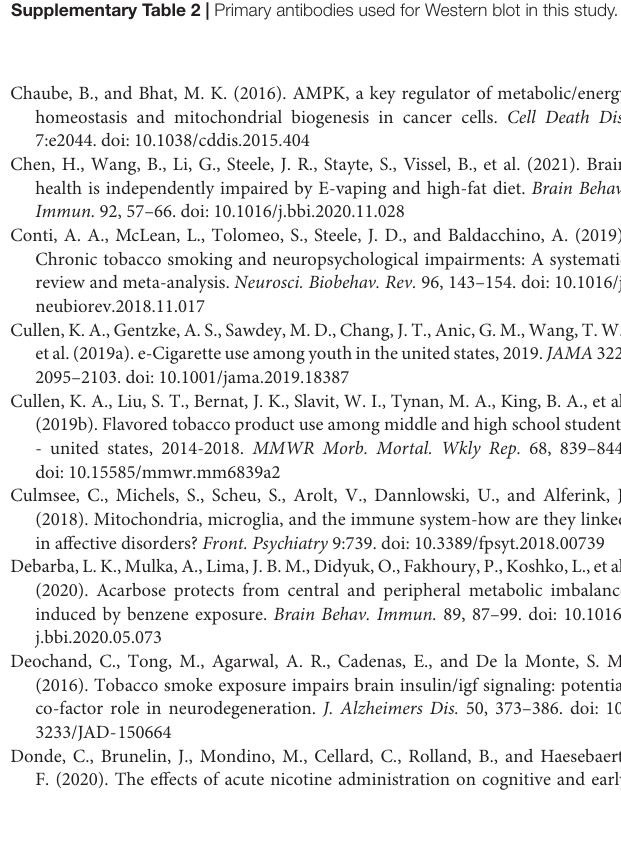
Supplementary Figure 1 | Urine cotinine measured during vapor exposure. The urine samples from the mice of all exposure groups were collected immediately following the daily exposure period and assessed by Liquid chromatography-mass spectrometry (LC-MS/MS) for cotinine as a marker for the intake of nicotine-containing vapors. Data are expressed as group mean ± standard error. ∗ p < 0.05, ∗∗ p < 0.001 as determined by ordinary one-way ANOVA and multiple comparisons with every other group. Veh cont, Vehicle control; Nico, Nicotine; Nico + ment, nicotine with menthol flavor. Supplementary Figure 2 | Weight measured weekly during vapor exposure. (A) Weight measured weekly from week 0 to week 12. (B) Delta weight gain corrected for physiological growth, as measured in the weight value of the following week minus the weight value of the first week. Data are shown as mean ± SEM. ∗ p < 0.05. Veh cont, Vehicle control; Nico, Nicotine; Nico + ment, nicotine with menthol flavor. Supplementary Table 1 | Device parameters of e-cigarette vapor exposure program. Supplementary Table 2 | Primary antibodies used for Western blot in this